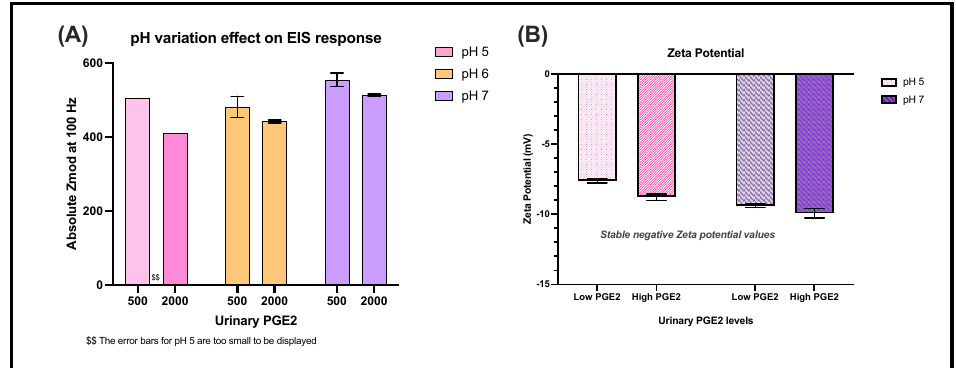
Figure 6. ( A ) Effect of pH on sensor response and ( B ) variation in zeta potential of the PGE2 antibody-antigen conjugate post binding at urine pH 5 and pH